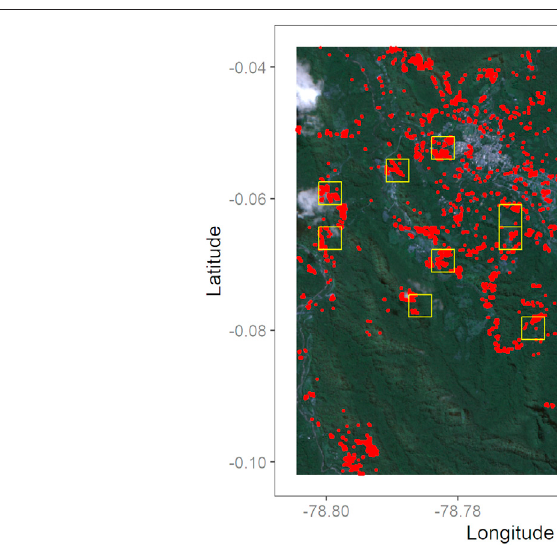
FIGURE 12 | Individual red dots show areas of tree cover loss in Mindo. Yellow boxes indicate tiles where tree cover loss equaled or exceeded 5% of the tile area. Based on our model results, the total area of tree cover loss between August 2019 and July 2021 is 0.61 km 2 — 1.17% of the study area.